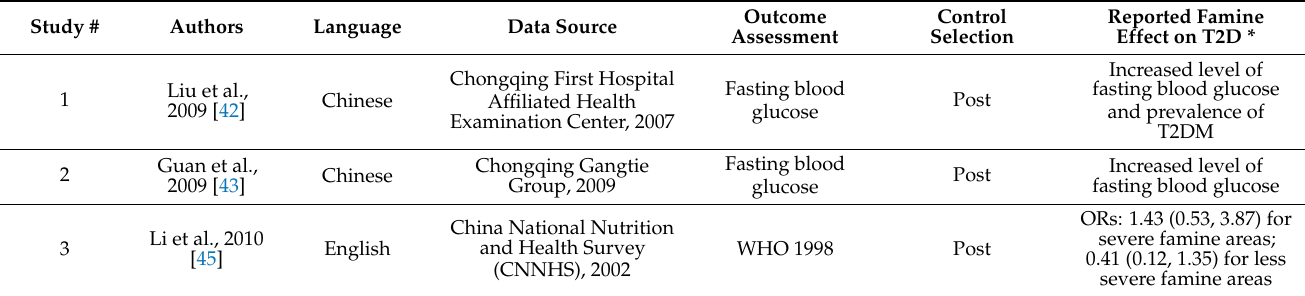
Figure 2. Flow diagram of study inclusion. Table 1. Main characteristics of Chinese famine studies on type 2 diabetes